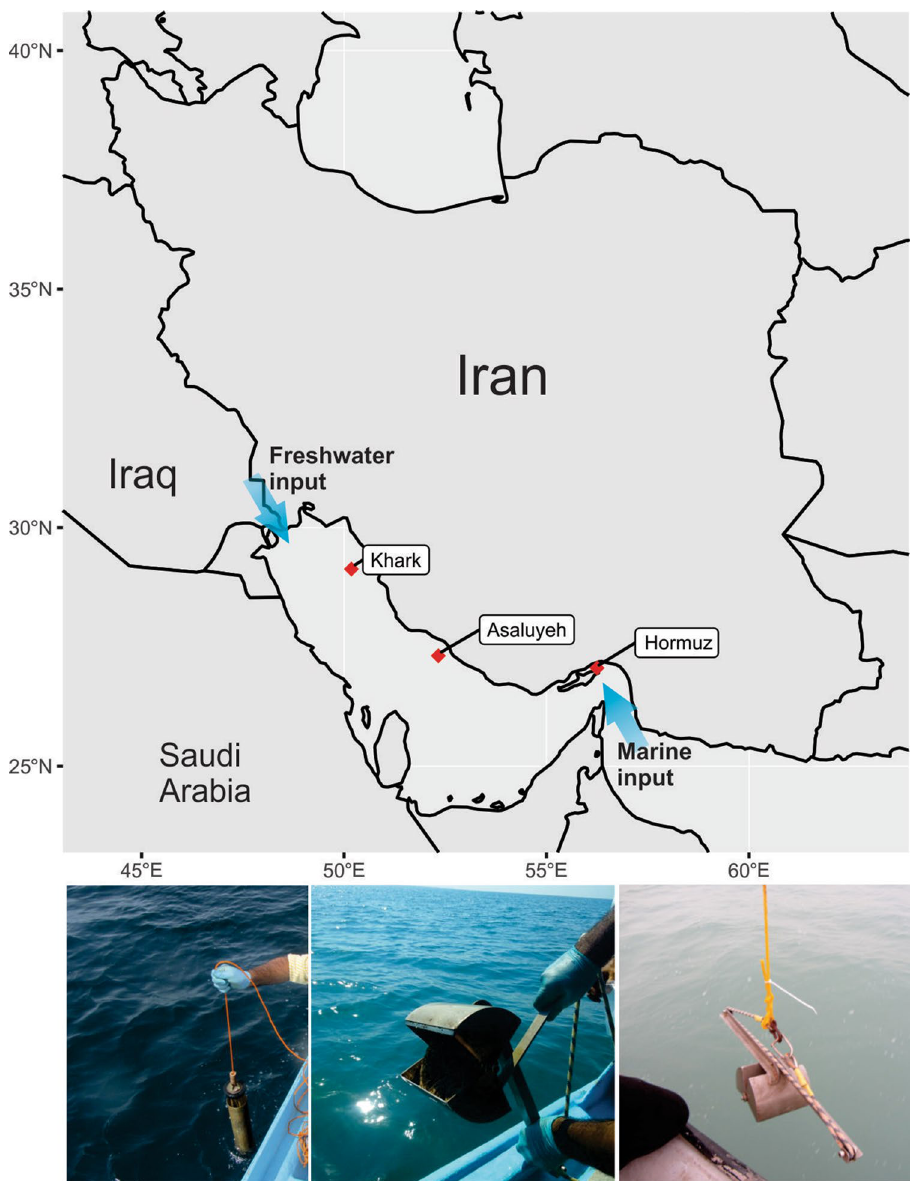
Figure 1. Geographical location of the sampling sites along the pollution continuum of the Persian Gulf. Hormuz sampling point is located close to the Persian Gulf’s marine input water, Asalouyeh sampling point is mainly exposed to aromatic oil contaminants and Khark sampling point is exposed to pollution with different crude oil derivatives. Sampling locations are marked with red squares. Figure was plotted using the open-source maps of the “rnaturalearth” library in